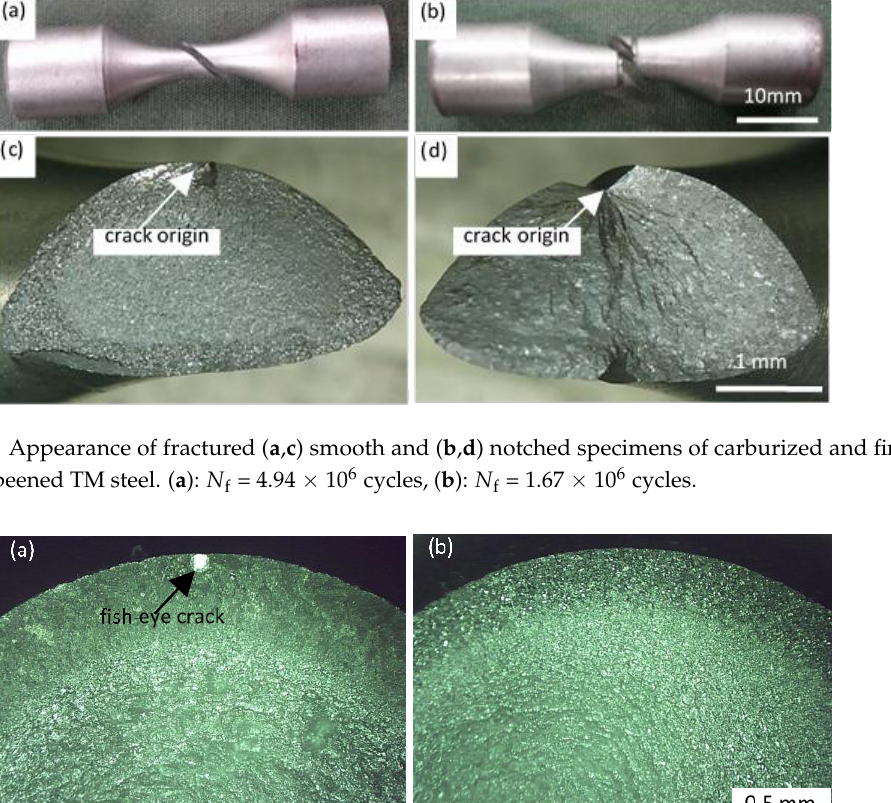
Figure 9. Relationships between torsional (  w ,  wn ) and rotational bending ( σ w , σ wn ) fatigue limits of TM (● ○ ) and SNCM420 ( ▲ △ ) steels subjected to ( a ) vacuum carburizing and subsequent fine particle peening and ( b ) heat-treating and subsequent fine particle peening.  = σ ，  = σ √3 and  = σ /2 are